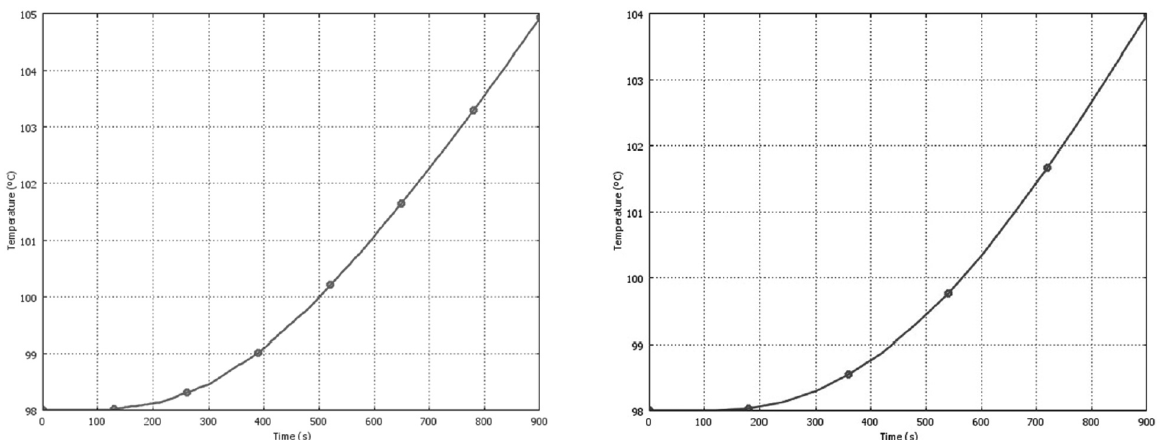
Figure 5. Evolution of the predicted temperature in the thermal center of the container for both domains, 2D (a) and 3D (b)